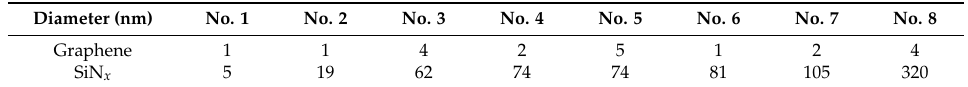
Table 1. Geometric parameters of nanopores.